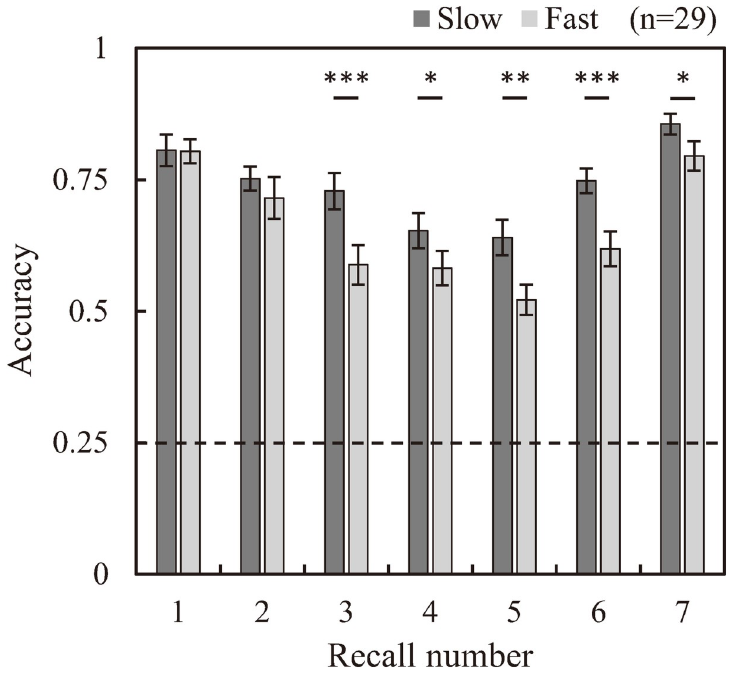
Fig 2. Comparison of recall accuracy between the slow and fast tasks according to each recall number. Significant differences in accuracies between tasks were observed for the direction of arrows (memory items) presented from the third to the last position in the sequence. The dashed line denotes the chance accuracy level in both tasks of 0.25. (n = 33, Error bar: SE, � : p < 0.05, �� : p < 0.01, ��� : p < 0.001).